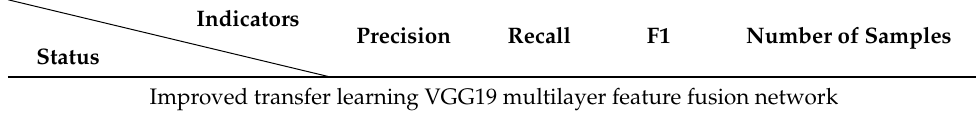
Table 3. Performance comparison of the two network models on the test